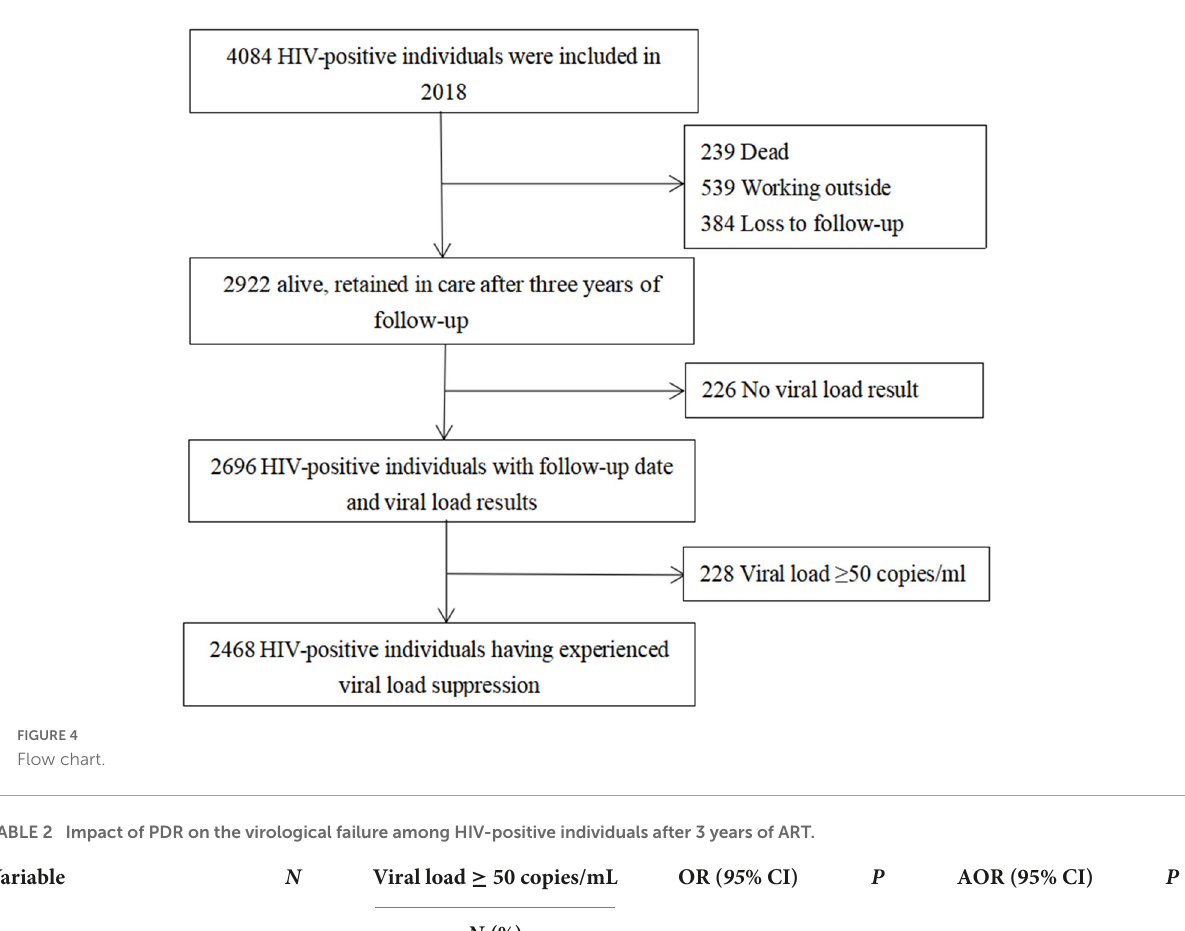
TABLE 2 Impact of PDR on the virological failure among HIV-positive individuals after 3 years of